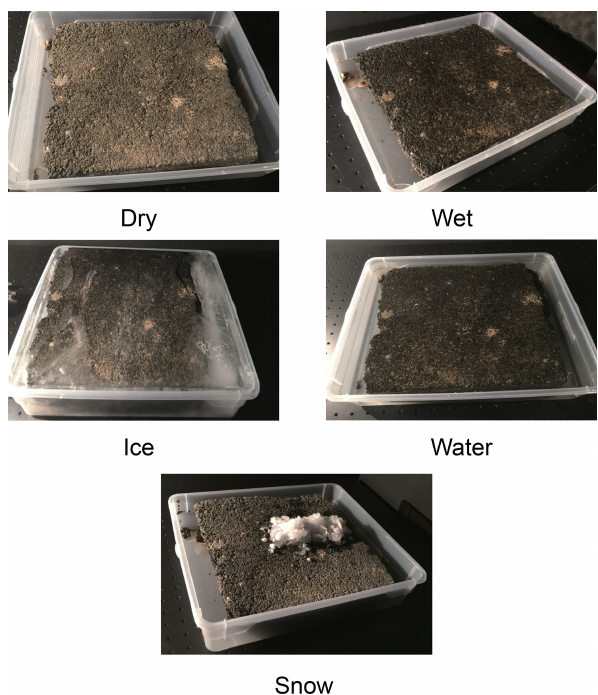
Figure 4. Images of the asphalt samples under the different condi- tions